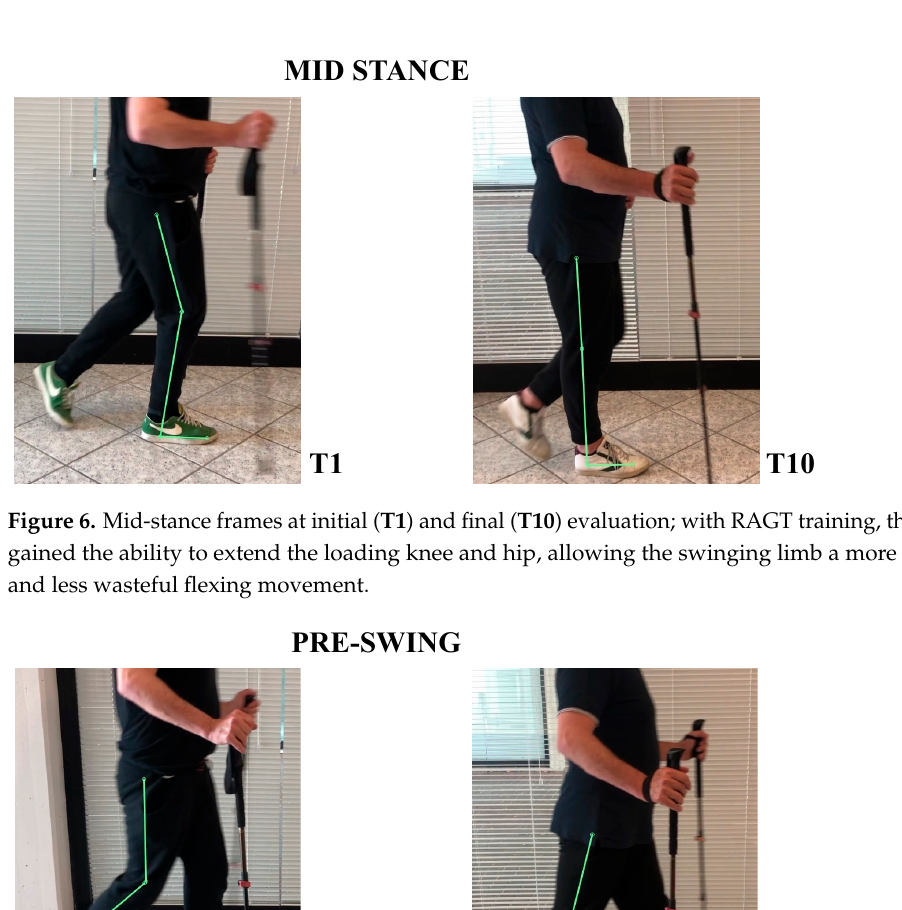
patient gained a better alignment of the trunk and lower limb, with the onset of a real “heel strike”